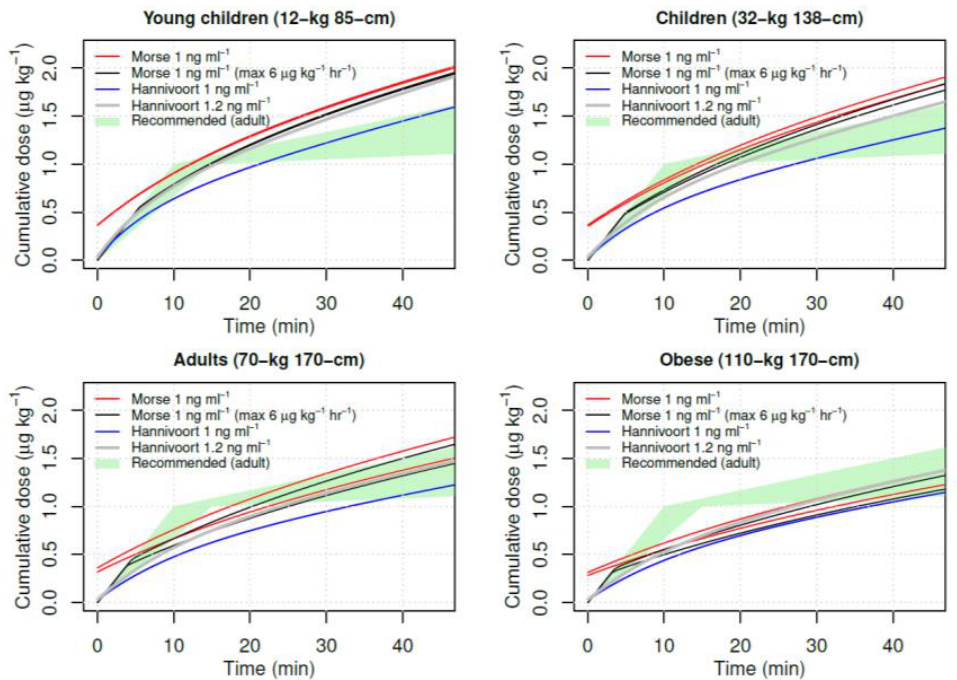
Figure 1. Simulation of dexmedetomidine TCI for the Morse (1 ng/mL) (male and female) and Hannivoort (1 ng/mL and 1.2 ng/mL) models along with recommended dosing ranges in adults (1 μg/kg over 10 – 15 min, thereafter 0.2 –1 μg/kg/h ).